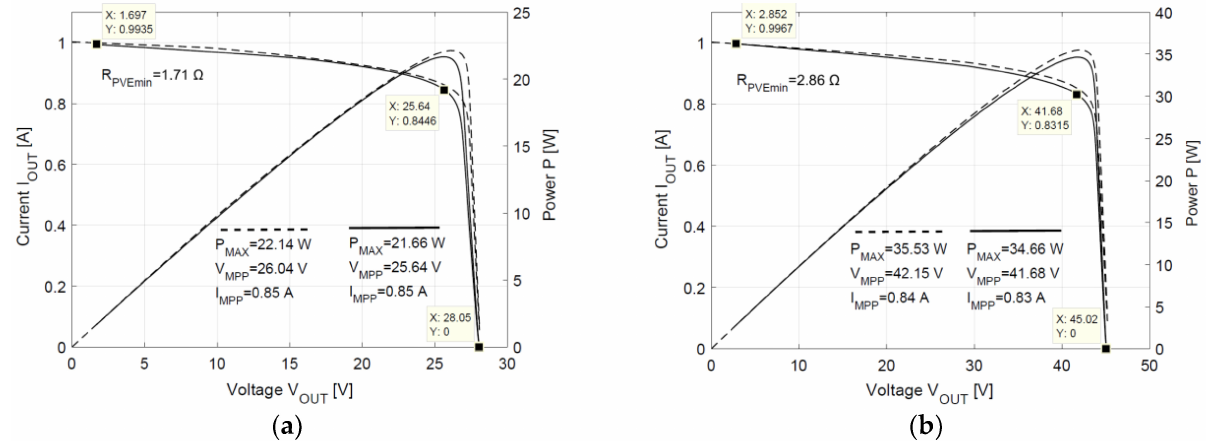
Figure 10. Simulation and measurement results of emulated characteristics I–V and P for I OUT range from 0 to 1 A: ( a ) For voltage V OUT equal 28 V; ( b ) For V OUT equal 48 V. The minimum values of the output resistance R PVEmin are specified.